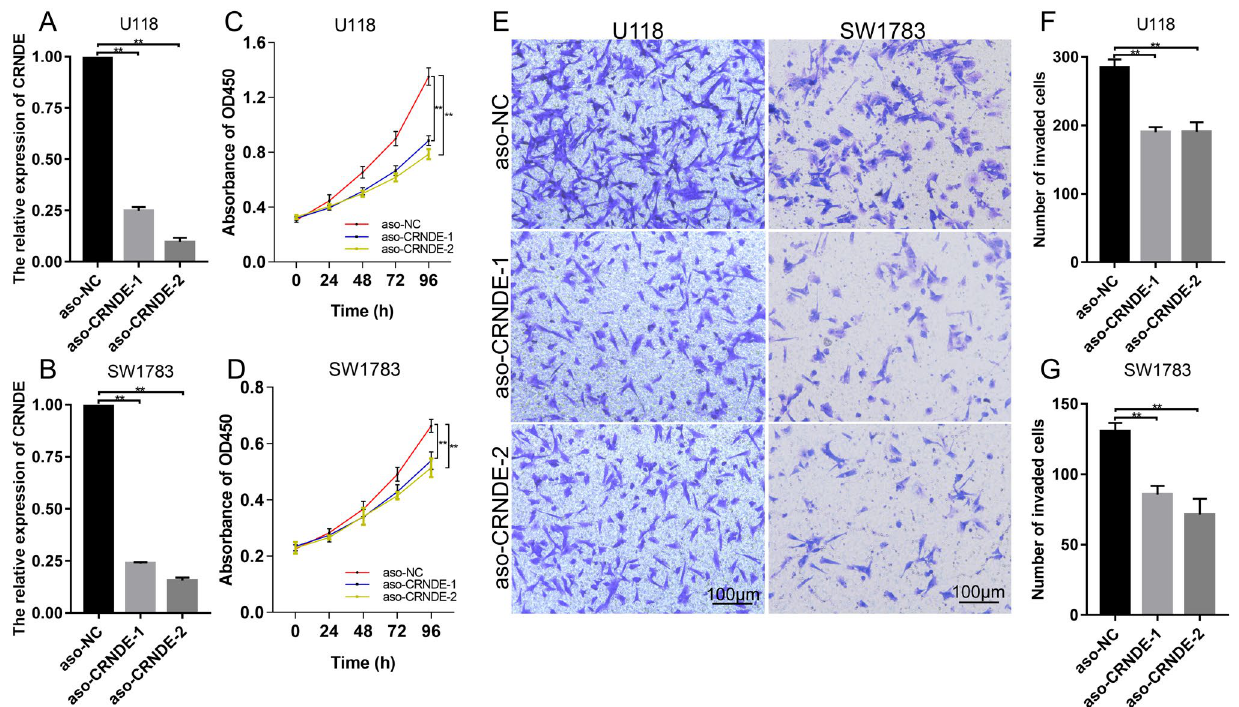
Figure 10. Effects of CRNDE knockdown on the proliferation and invasion of glioma cells. ( A , B ) Knockdown efficiency of CRNDE in U118 and SW1783 verified with RT-qPCR. The mean expression level of GAPDH, β -actin, and α -tubulin was used as the endogenous control. ( C , D ) Effect of CRNDE knockdown on the proliferation of glioma cells. ( E – G ) Effect of CRNDE knockdown on the invasion of glioma cells (** p < 0.01).